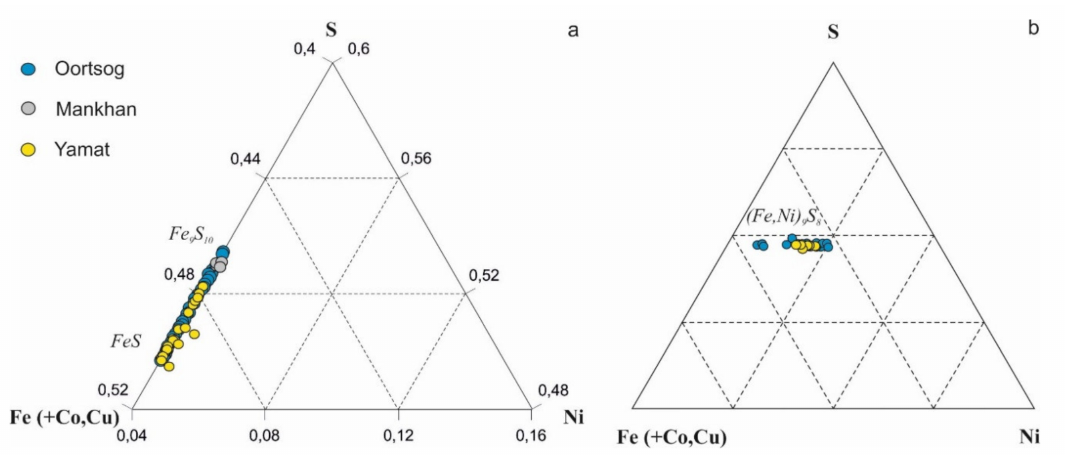
Figure 6. The composition of sulfides in the mafic-ultramafic massifs of the Khangai upland on the Fe( + Co,Cu)–S–Ni diagram: ( a ) pyrrhotite; ( b )